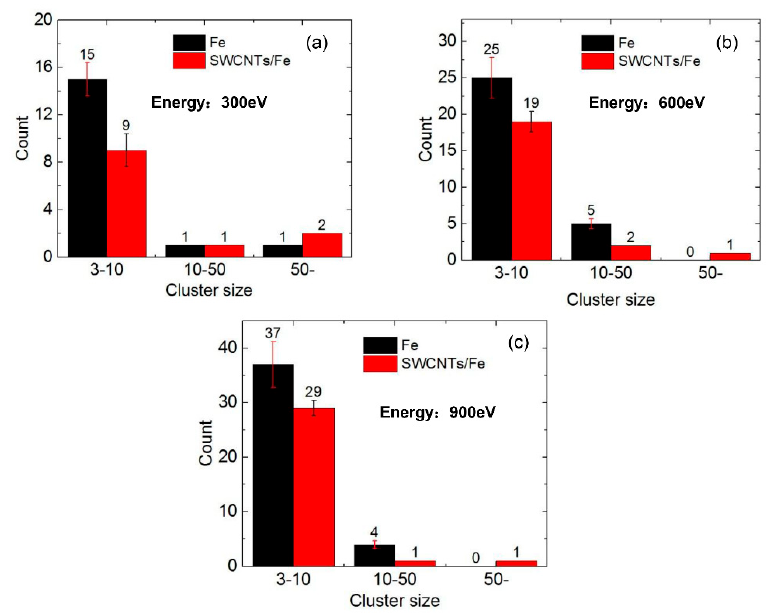
Figure 5. The number of He clusters in the Fe matrix and the SWCNT/Fe composite, t = 1200 ps. The incident energies of the He atoms were ( a ) 300 eV; ( b ) 600 eV; and ( c ) 900 eV.